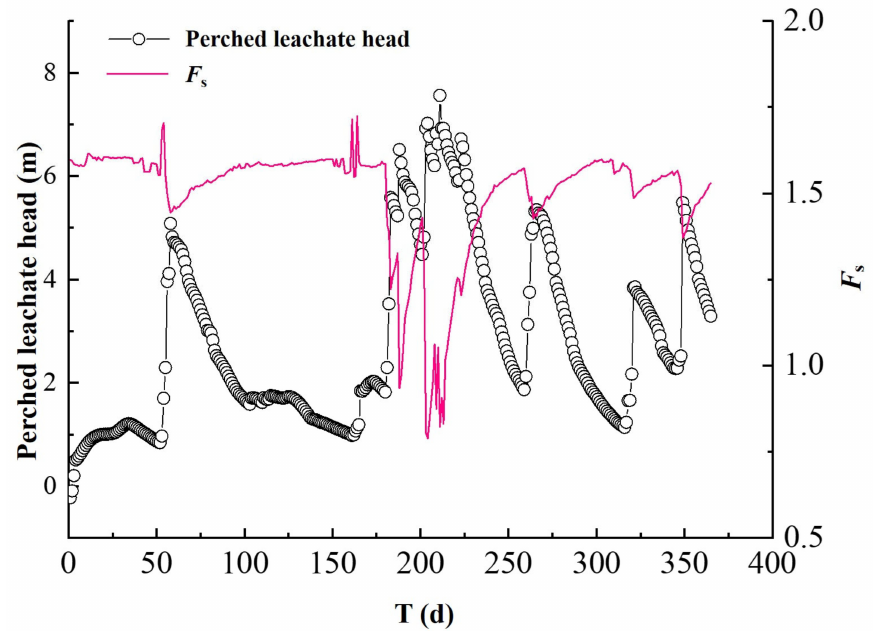
Figure 11. The perched leachate head and the safety factor.